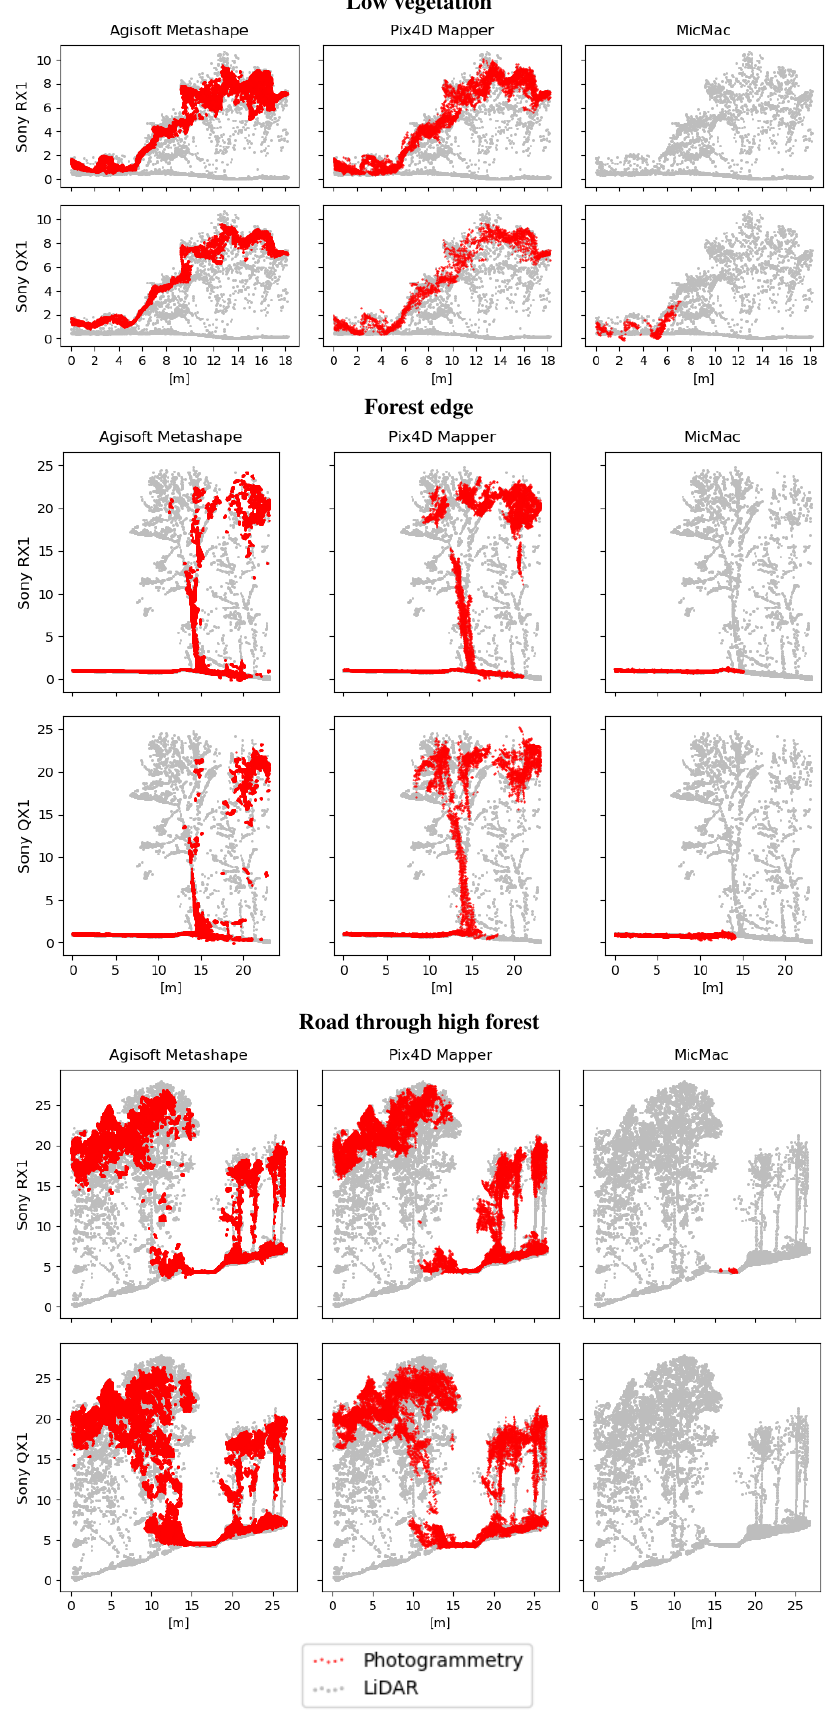
Figure 8: Cross sections - Forest, low vegetation area (top), forest border (middle), and road through high forest